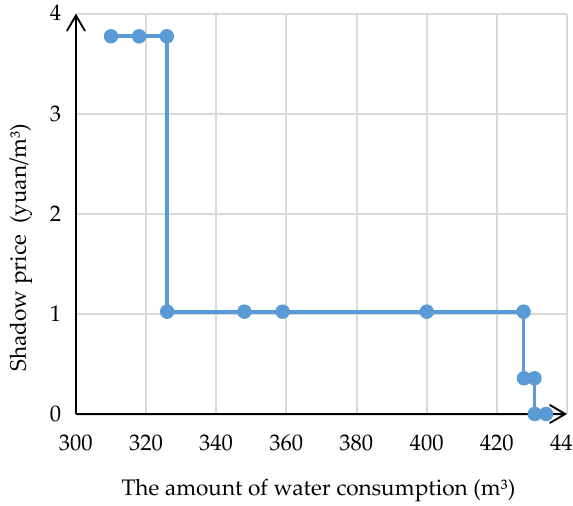
Figure 2. Shadow price of agricultural irrigation water.